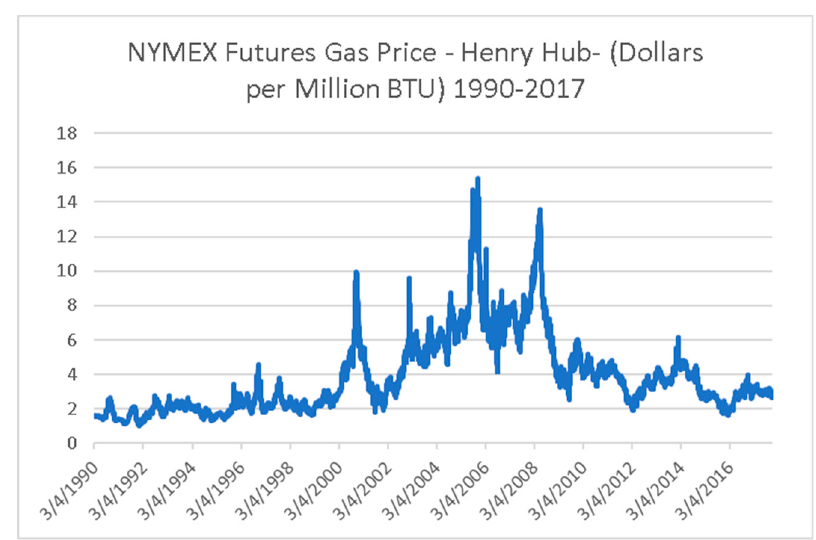
Figure 2. NYMEX Futures gas price-henry hub-(dollars per Million British Thermal Units (BTU)) 1990–2017.